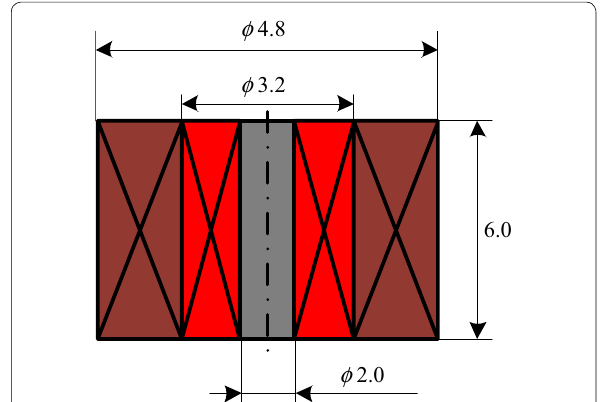
Figure 9 Geometrical model of mutual-induction probe (unit: mm)